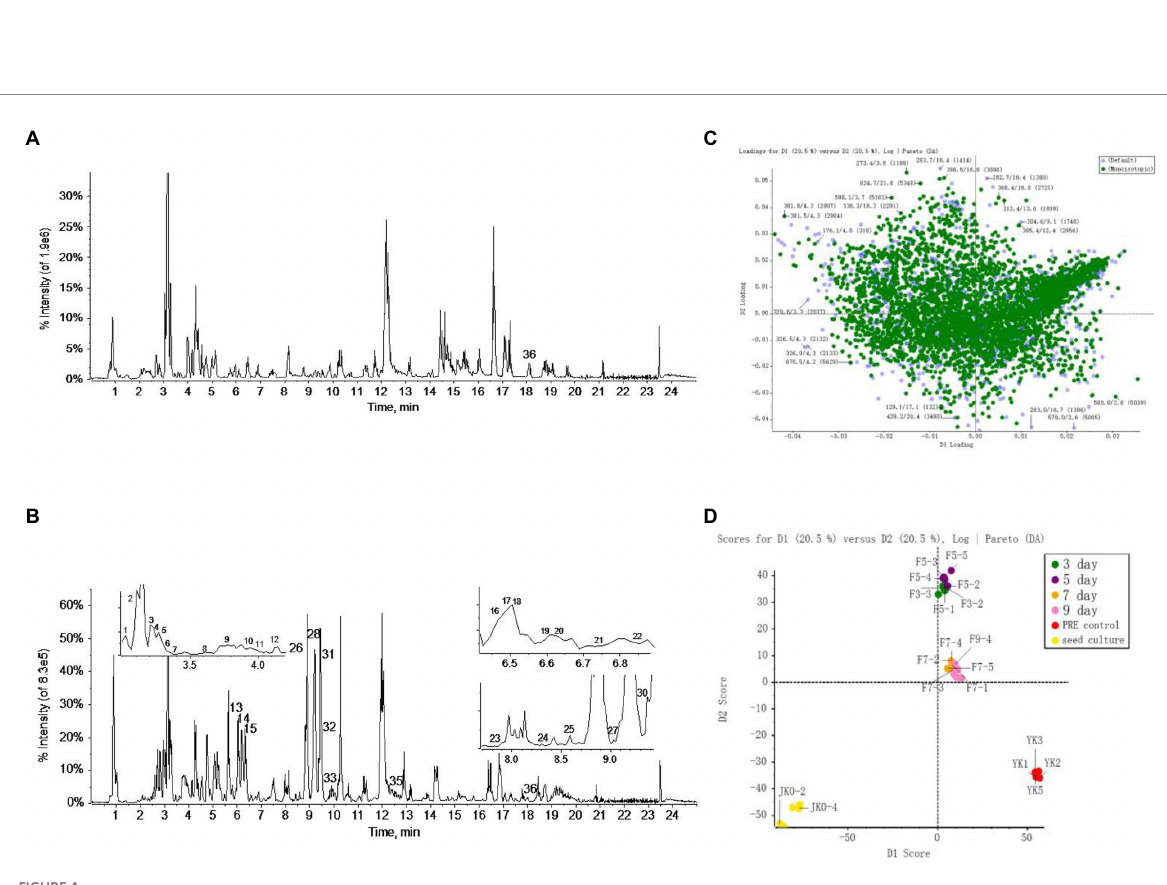
FIGURE 4 The screening of differential saponins during liquid fermentation of PRE by strain C39 at ESI + . (A) BPC chromatograms of UPLC-MS for sample group and (B) seed culture solution group. (C) PCA scores plot and (D) loadings plot of all